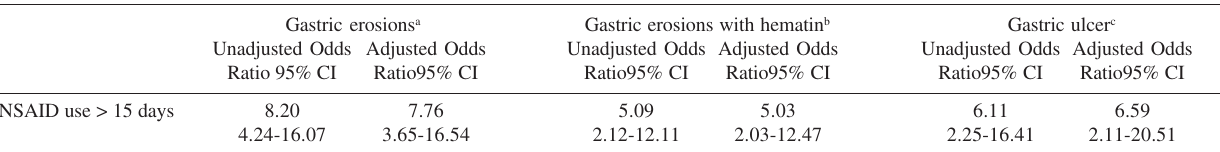
Table 4 - Results of multivariate analysis of association between nonsteroidal anti-inflammatory drugs (NSAID) use for more than 15 days and the occurrence of gastric lesions